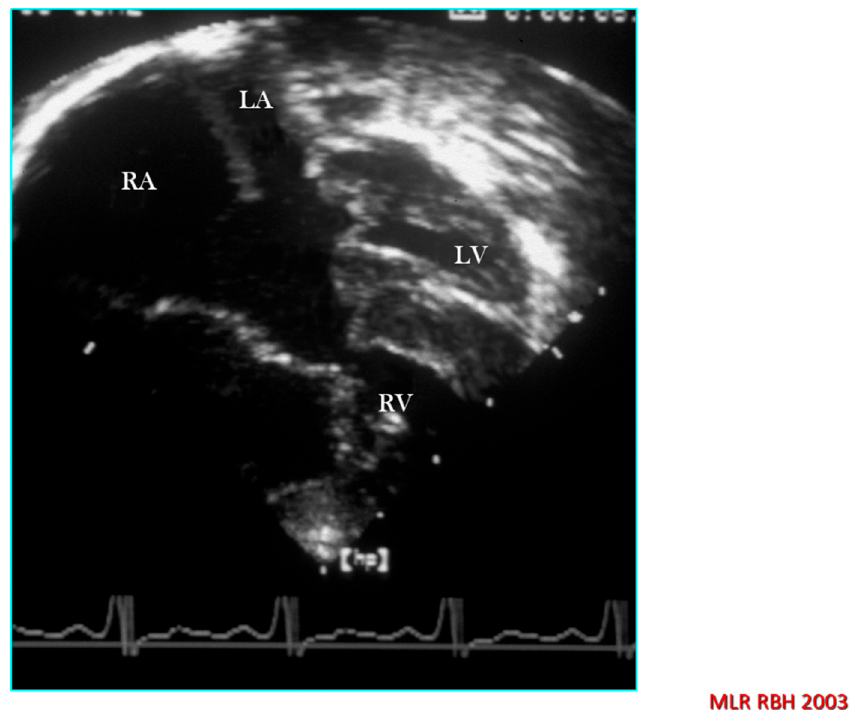
Figure 12. Echocardiographic four chamber section from a heart with partial AVSD, hypoplastic left ventricle and miniaturised left atrioventricular valve orifice.